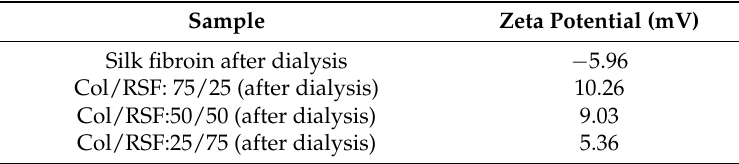
Table 3. ζ potential of collagen/RSF blends after dialysis (the ratios are those before dialysis). Sample